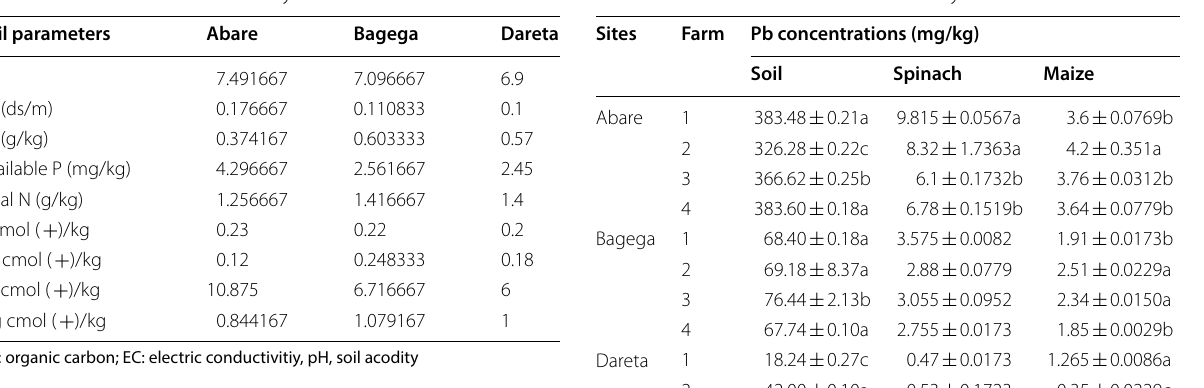
Table 3 Pb concentration (mg/kg), in soil, spinach and maize from the cultivated land across the study sites